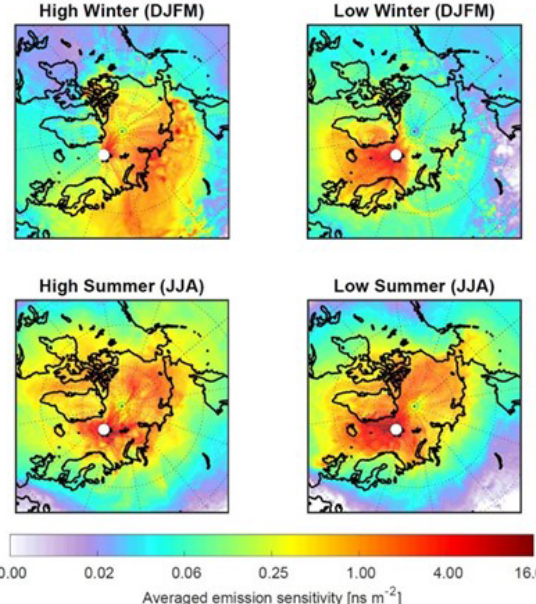
Figure 5. FLEXPART footprint emission sensitivities for a black carbon tracer for the 10% highest (left) and 10% lowest (right) val- ues of the measured aerosol absorption coefficient (equivalent black carbon), based on data for the years 2014 to